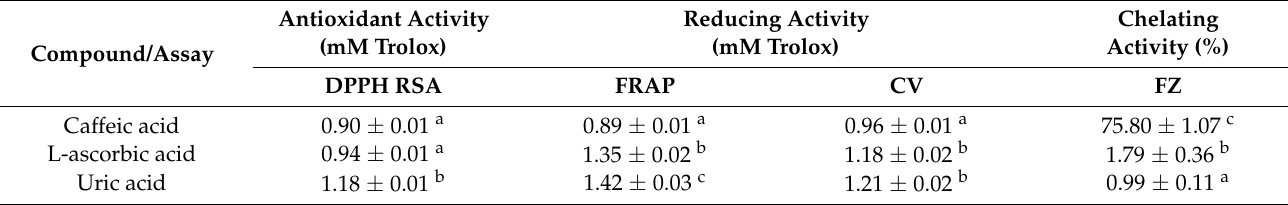
Table 2. The antioxidant, reducing, and chelating activity of caffeic acid vs. L-ascorbic and uric acids. Antioxidant Compound/Assay